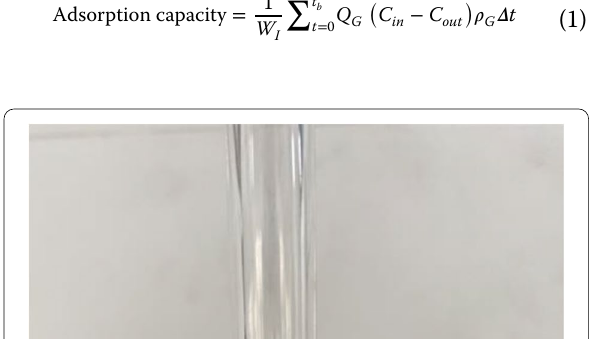
the center of the reactor, coming into contact with two stainless steel conductive rods, which allowed the cur- rent to pass through. As the direct current (DC) and volt- age were applied to the KBAC via a DC power supplier (ITECH model IT6721), the temperature of the KBAC bed increased due to the Joule effect resulting from the hetero- geneously distributed conductive and resistant structures within KBAC as the current passed through. The targeted regeneration temperatures of the KBAC fixed bed, moni- tored by a K-type thermocouple inserted in the fixed bed and read out and controlled by a temperature controller, were set to 120, 140, and 160 °C by applying suitable power to the fixed bed ranging from 2 to 2.5 W. The applied power was manually adjusted to the target temperature and lasted for approximately 90 and 50 min for TOL and MEK desorption, respectively. The desorbed VOC outlet concentration was detected by the THC analyzer with N 2 as the carrier gas (1.6 SLPM). All the tests were triplicated. Desorption efficiency is described as in Eq. (3):